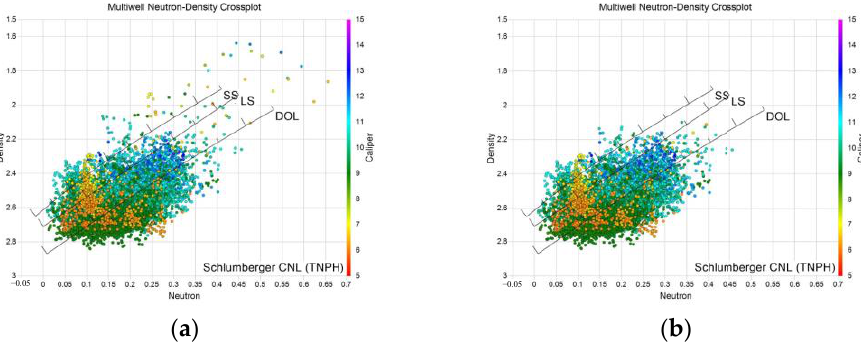
Figure 7. Crossplot of CNL and RHOB logging before ( a ) and after ( b ) the correction (color-coded by caliper curve).